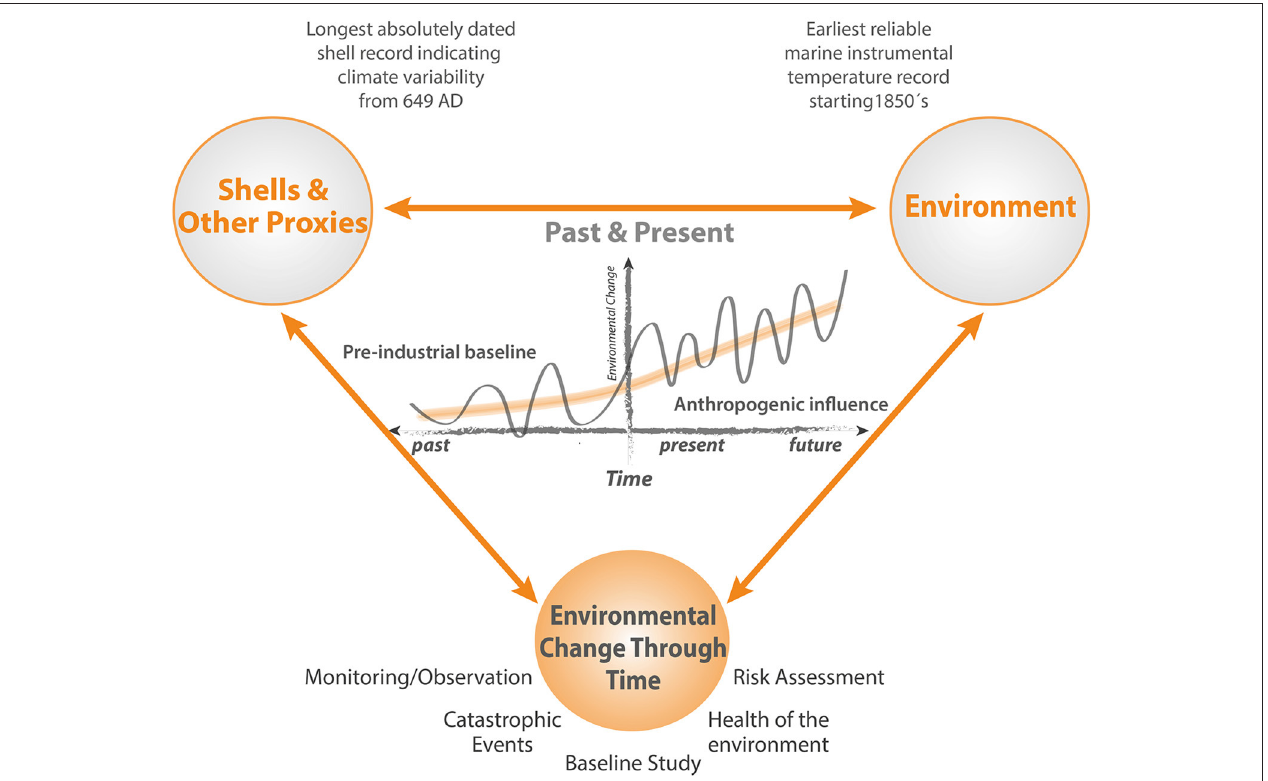
FIGURE 1 | Schematic illustrating how cycles, trends, regime shifts and extrema are expressed in the context of an extended baseline. Short periods of monitoring reveal only a small fraction of the full picture. High resolution multidecadal and multicentennial timeseries based on bivalve sclerochronology can provide insights into the full range of natural and anthropogenically forced environmental variability, enabling a much more realistic and reliable approach to monitoring and risk assessment